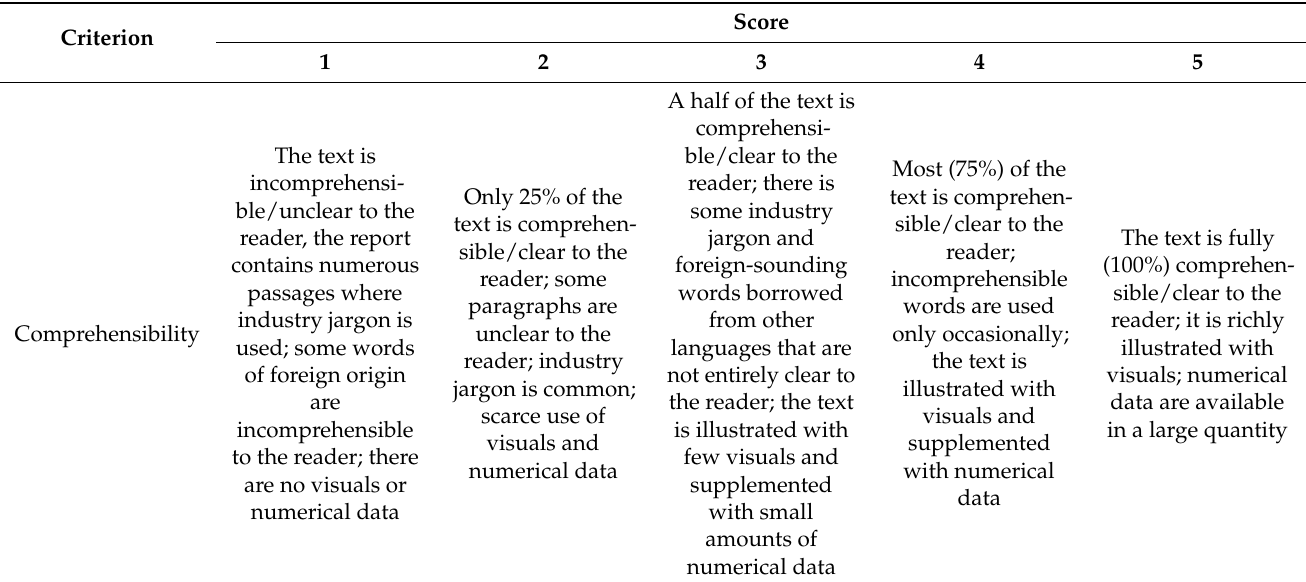
Table 6. Description of the scale used to measure information quality according to the adopted